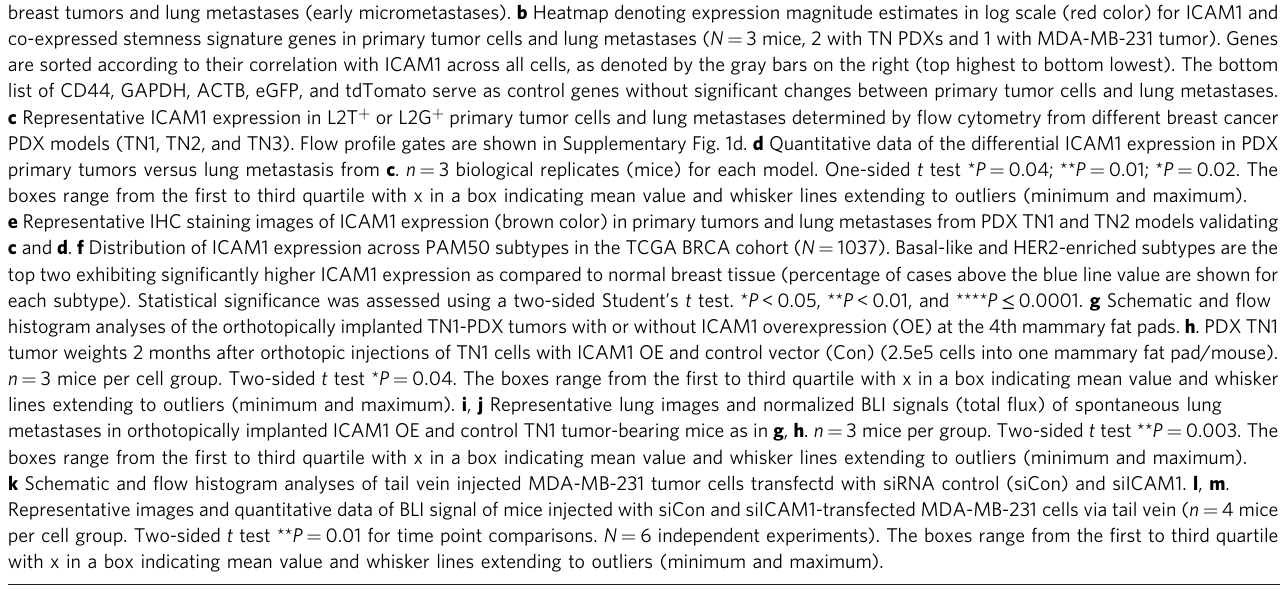
TNBC cells, ICAM1 + CD44 + double positive cells showed a better clustering ef fi ciency with more than 5-fold bigger clusters (Supplementary Fig. 4f), indicating a potential cooperation between ICAM1- and CD44-mediated two independent pathways in cell aggregation.